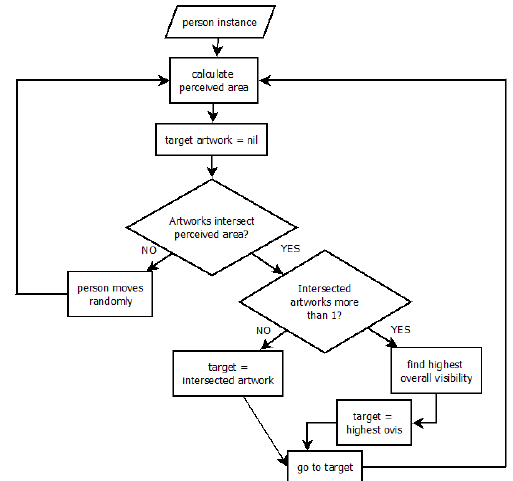
Figure 8. The flowchart showing the sequence of instructions for people agent mobility.